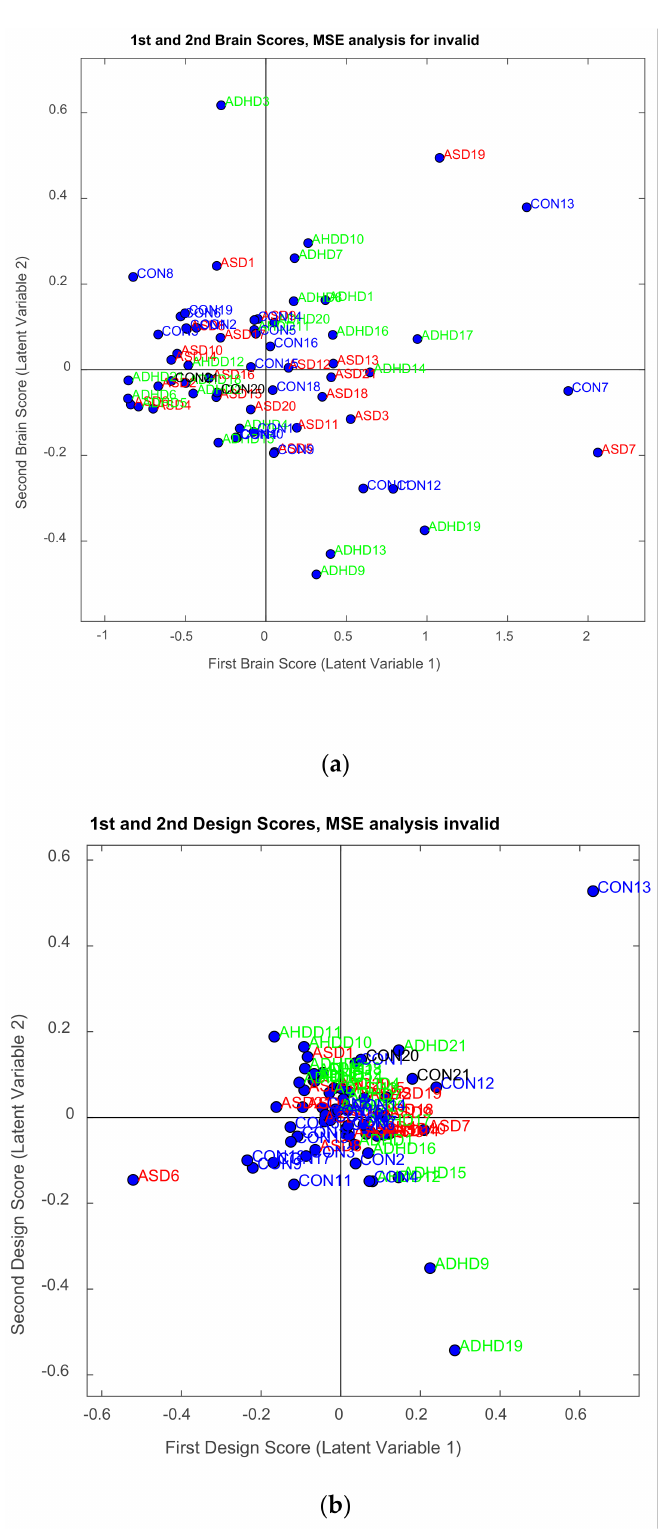
Figure 13. ( a ) Plot of first and second brain scores ( latent variables ), based on the average per subject MSE, for invalid type of syllogism. ( b ) Plot of first and second design scores ( latent variables ), based on the average per subject MSE, for invalid type of